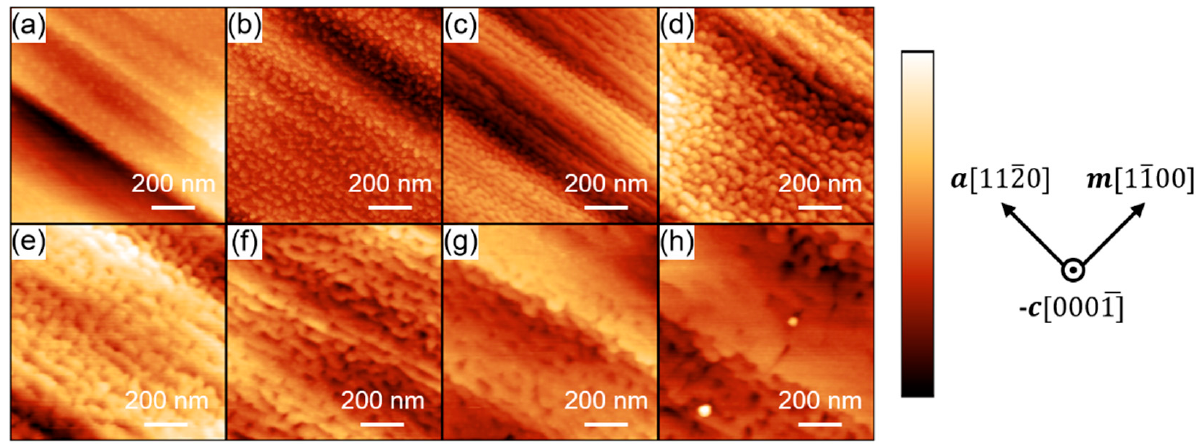
Figure 4. 1 × 1 µm AFM images of N − polar InN grown at 540 °C with different thicknesses. InN dash and wire − like structures are aligned along the a − direction. ( a ) 0.25 nm. ( b ) 0.5 nm. ( c ) 1 nm. ( d ) 2 nm. ( e ) 3 nm. ( f ) 5 nm. ( g ) 10 nm. ( h ) 20 nm. Vertical scale bar is 0–20 nm for ( a , c , g , h ) and 0–10 nm for ( b , d – f ).